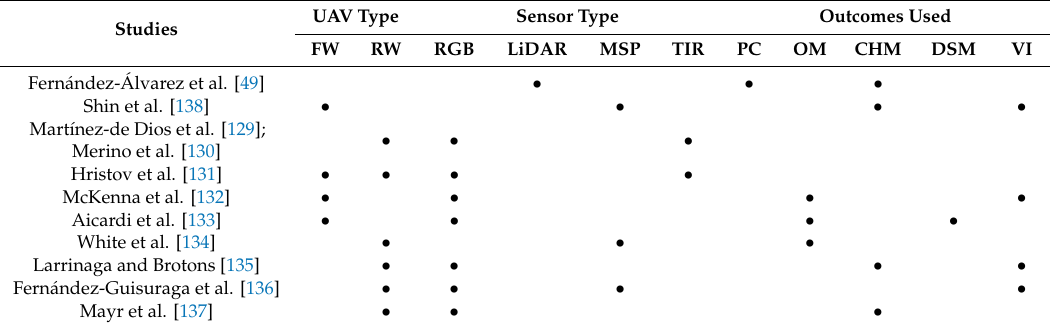
Table 4. Unmanned aerial vehicle type, sensing payloads and more significant outcomes used in fire and post-fire